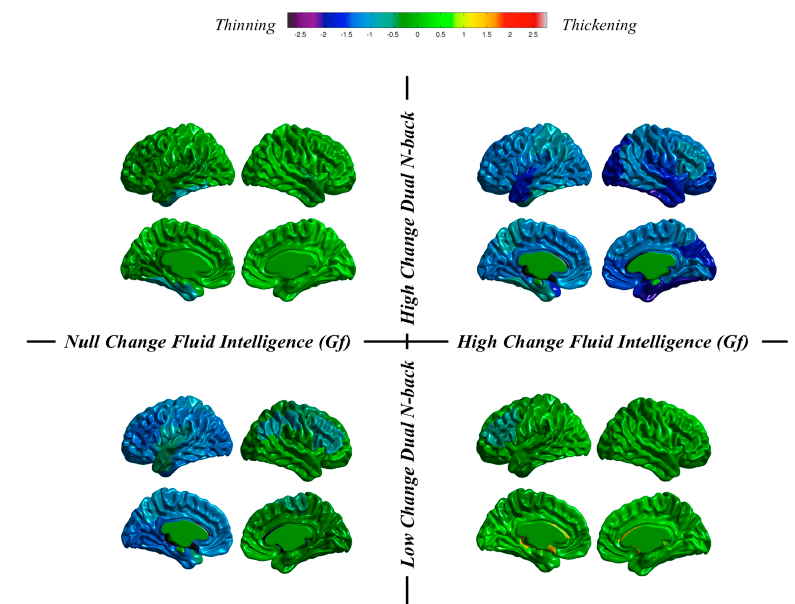
Figure 7. Thickness changes for individuals showing null changes in fluid ability and high changes in dual n-back ( top left ), high changes in fluid ability and high changes in dual n-back ( top right ), null changes in fluid ability and low changes in dual n-back ( bottom left ), and high changes in fluid ability and low changes in dual n-back ( bottom right ).